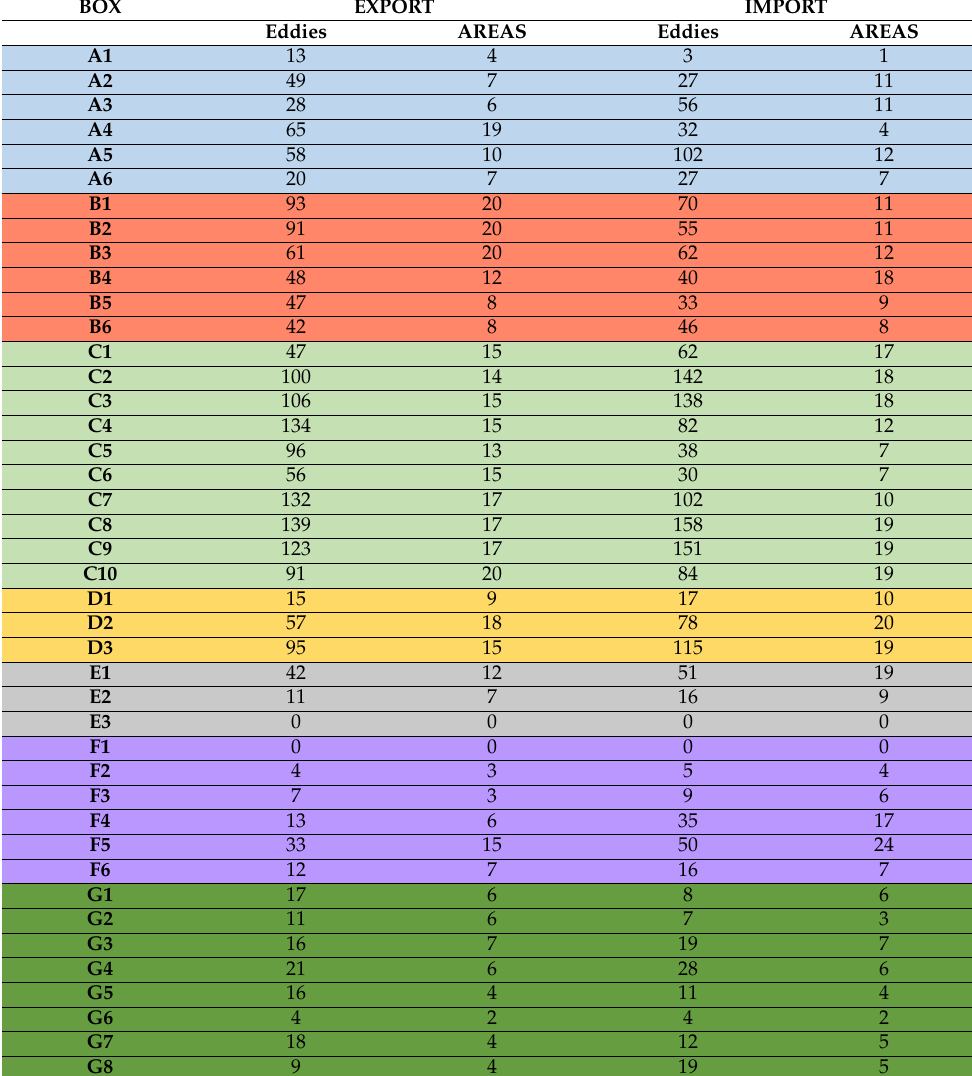
Table 1. Number of anticyclonic eddies exported and imported for each 1 ◦ × 1 ◦ cell of the WMED. The number of bins connected to each cell are also indicated both for the exported and imported eddies. Areas are color coded according to Figure 4. BOX